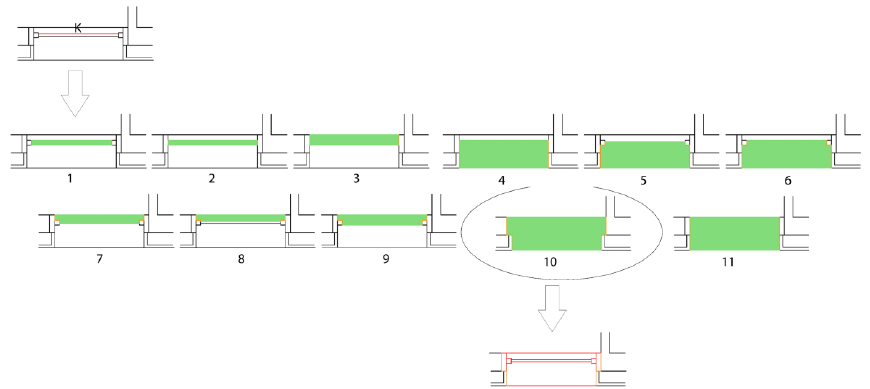
Figure 10. K represents the input line of the element. With the symmetry approach, 11 possible candidates are found. Symbol 10 is used as a symbol due to the thickness and shortest length.